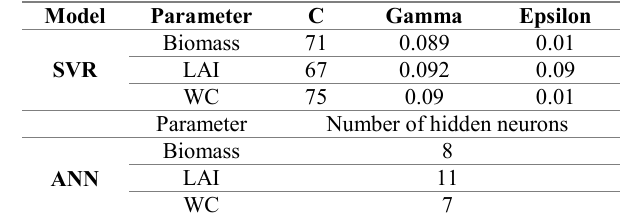
Table 1. Parameters used in ANN and